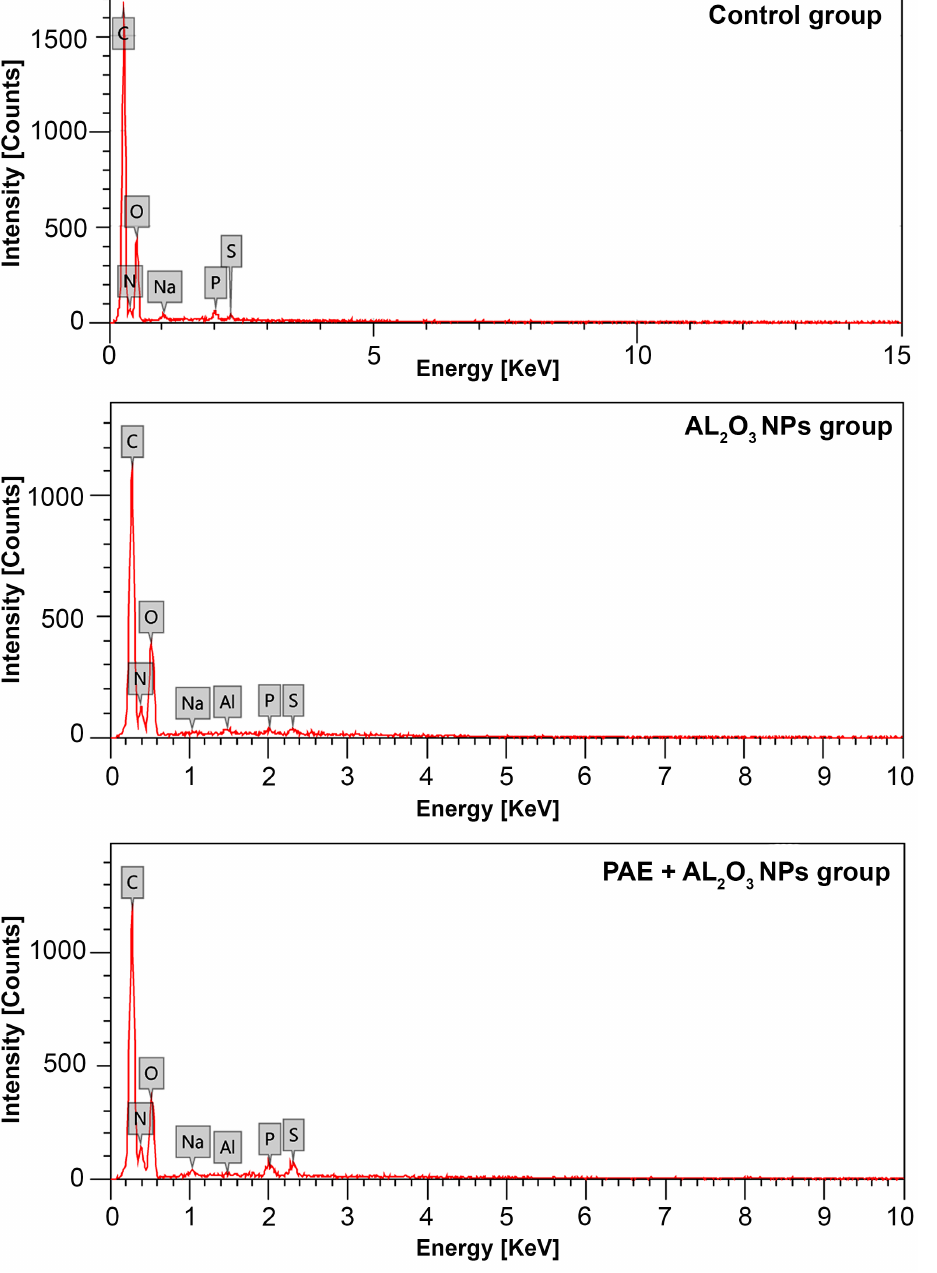
Figure 3. This is a figure. Schemes follow the same formatting. If there are multiple panels, they Figure 3. EDX analysis of testicular tissues harvested from control locusts, Al 2 O 3 NPs-treated locusts, should be listed as: ( a ) Description of what is contained in the first panel. ( b ) Description of what is and a group of locusts treated with PAE + Al 2 O 3 NPs, revealing an accumulation of Al in the Al 2 O 3 contained in the second panel. Figures should be placed in the main text near to the first time they NPs-treated groups, with different concentrations of Al in both treated are cited. A caption on a single line should be centered.